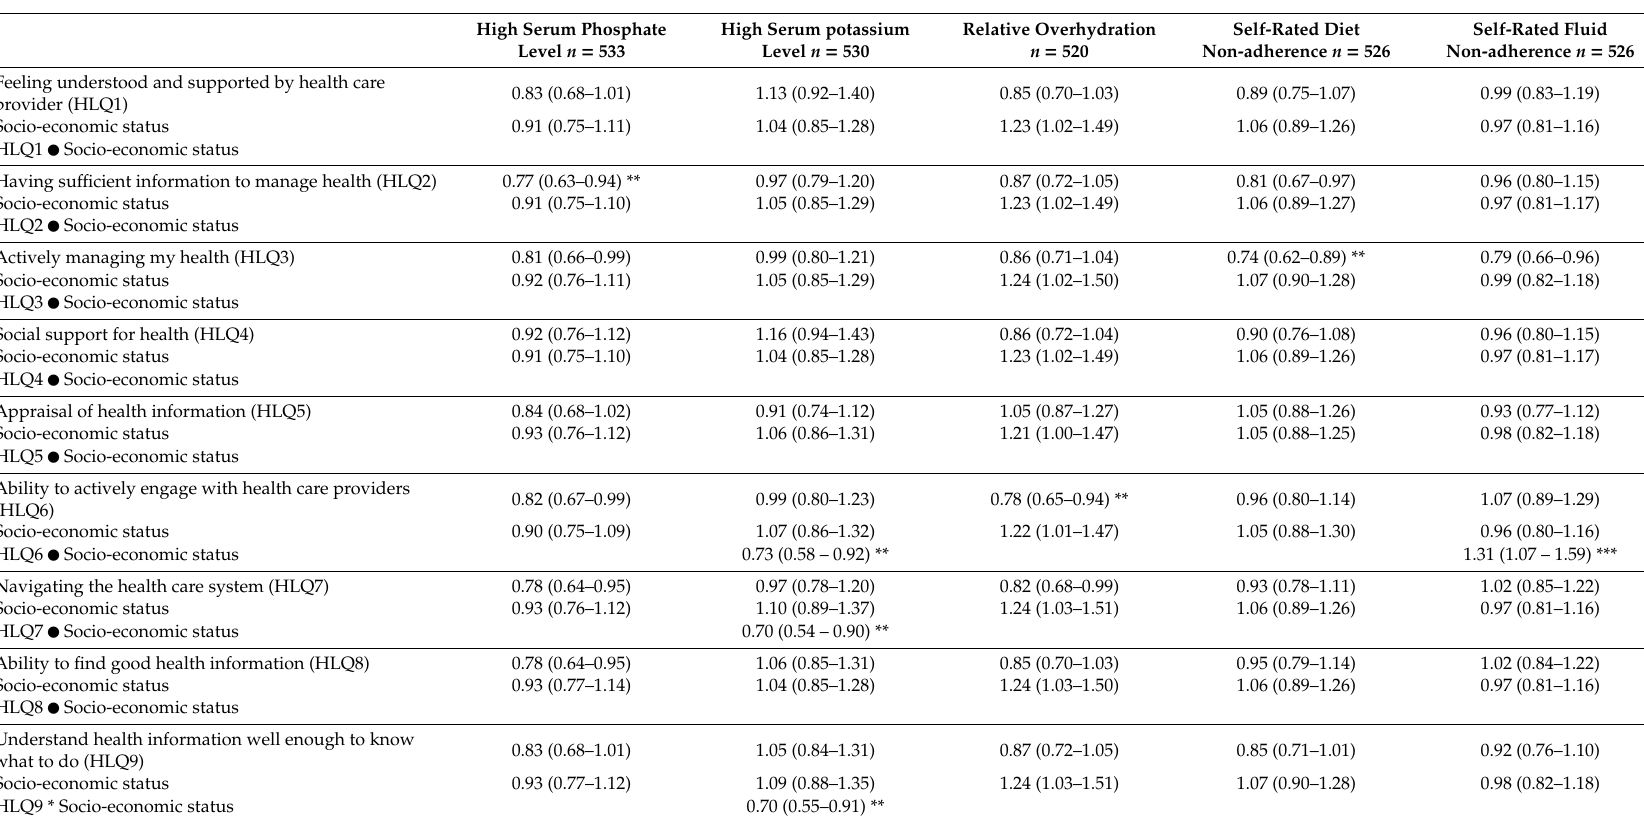
Table 2. The associations between health literacy domains and non-adherence, and the moderating e ff ect of socioeconomic status on the association between health literacy and non-adherence ( n = 542, patients from 20 dialysis clinics in Slovakia interviewed in 2018). General linear models adjusted for age and gender (odds ratio and 95% confidence